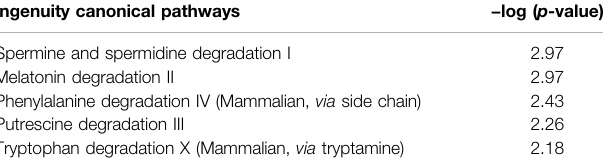
TABLE 2 | Top 5 conical